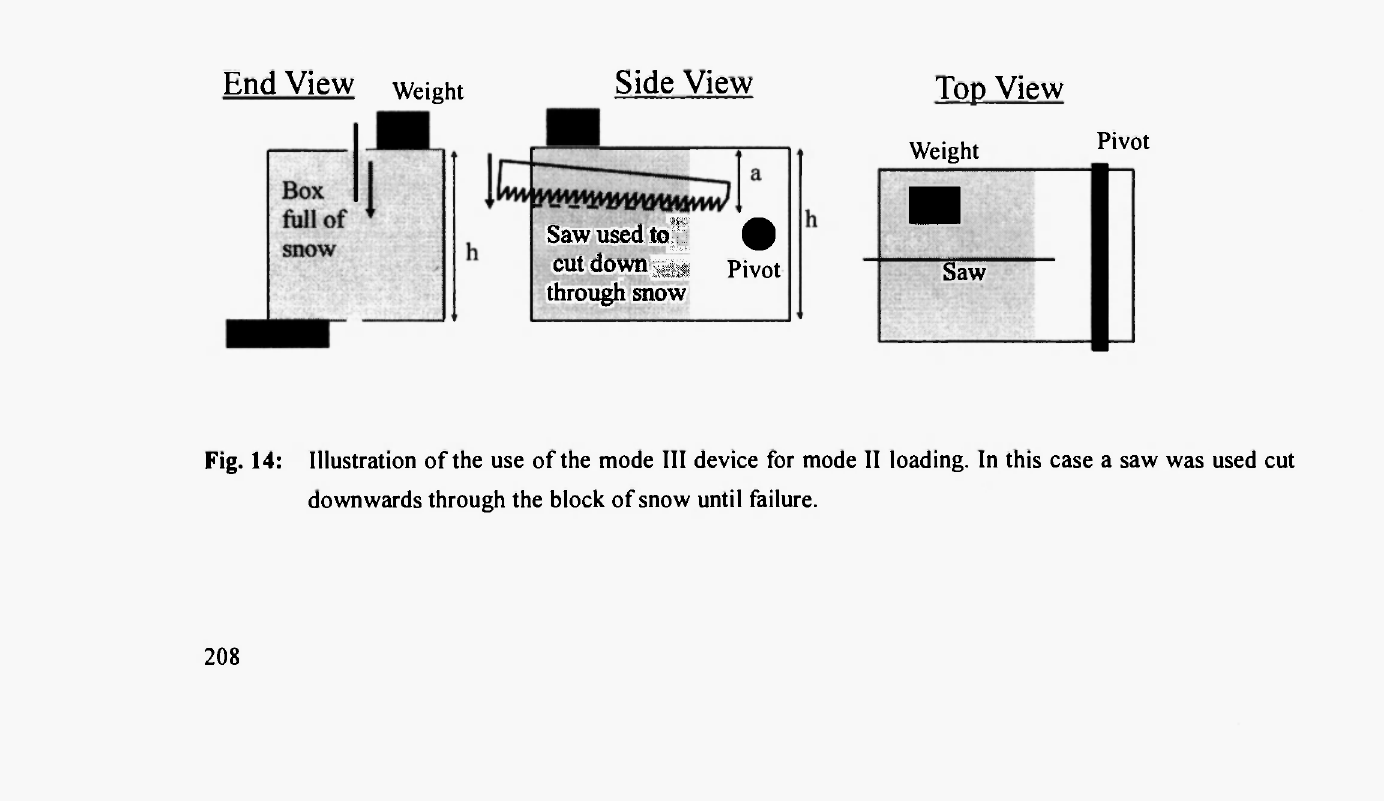
Due to the problems encountered, the mode II measurements were repeated using a different technique. This method used the mode III device (Figures 6 and 7). The set up was the same as for the mode III measurements, except that instead of cutting horizontally from the side of the block, the snow was cut vertically from the top (Figure 14). Due to the shape of the device it was awkward to cut with a string, so a small saw was used instead. Additional weights of up to 11 kg were added.